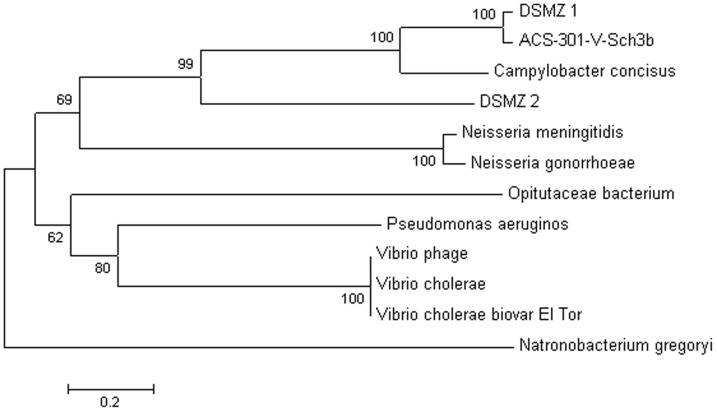
Evolutionary relationships of taxa Zona Occluden Toxin (ZOT).The evolutionary history was inferred using the Neighbor-Joining method. The percentage of replicate trees in which the associated taxa clustered together in the bootstrap test (1000 replicates) is shown next to the branches. The tree is drawn to scale, with branch lengths in the same units as those of the evolutionary distances used to infer the phylogenetic tree. DSMZ 1 and DSMZ 2 correspond to the ZOT paralogs in C. ureolyticus DSM20703. ACS-301-V-Sch-3b:C. ureolyticus ACS-301-V-Sch-3b.